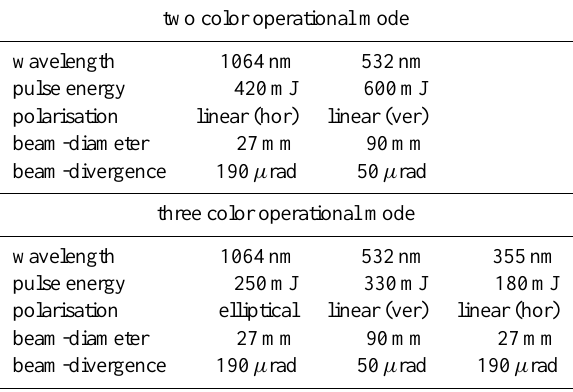
Table 2. Characteristics of transmitted